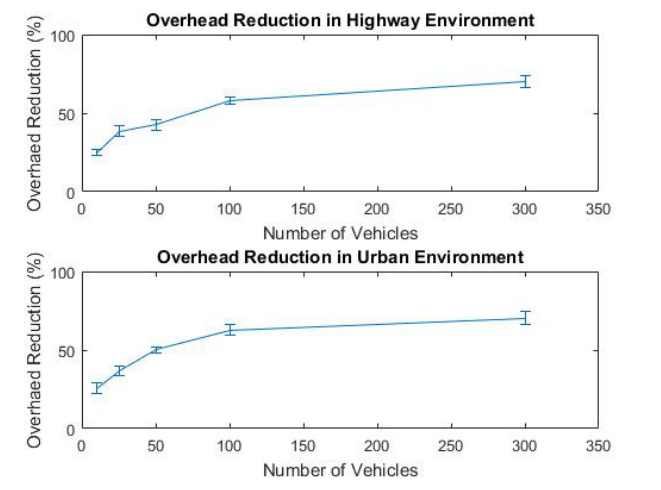
Figure 3. Overhead Reduction using a Bloom Filter.